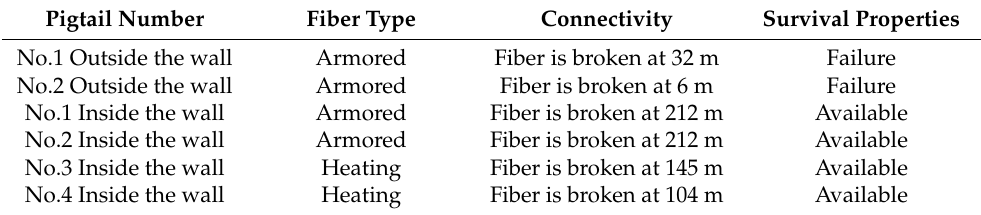
Table 4. Optical cable connectivity test table. Pigtail